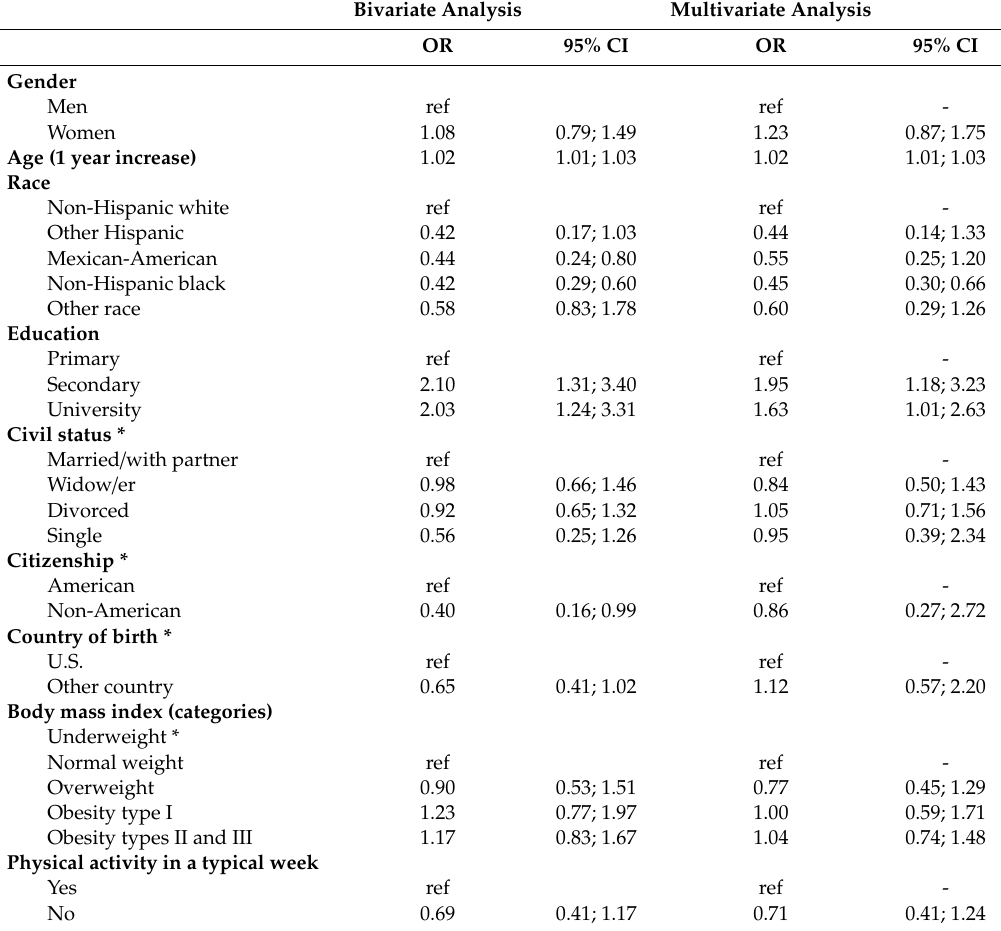
Table 3. Factors associated with potential interactions based on the multivariate weighted logistic regression model $